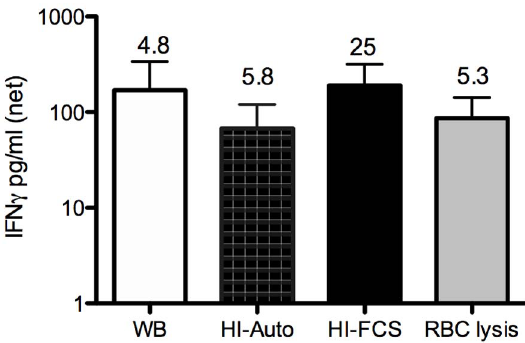
Figure 2. SLA induced IFN c secretion in WB of active VL patients is not dependent on plasma proteins or RBC. IFN c in SLA stimulated WB from active VL patients (n=8/9) following replacement of plasma or lysis or RBC as indicated (WB=whole blood untouched; HI-Auto=replacement with heat inactivated [12] autolo- gous plasma; HI-FCS=replacement with HI-FCS). Net responses (stimulated minus unstimulated) + SD are shown. The stimulation indices (stimulated/unstimulated) are indicated above each bar to as an additional comparison. Comparisons between treatments were made using Wilcoxon matched paired test; there were no significant differences between the different culture conditions.